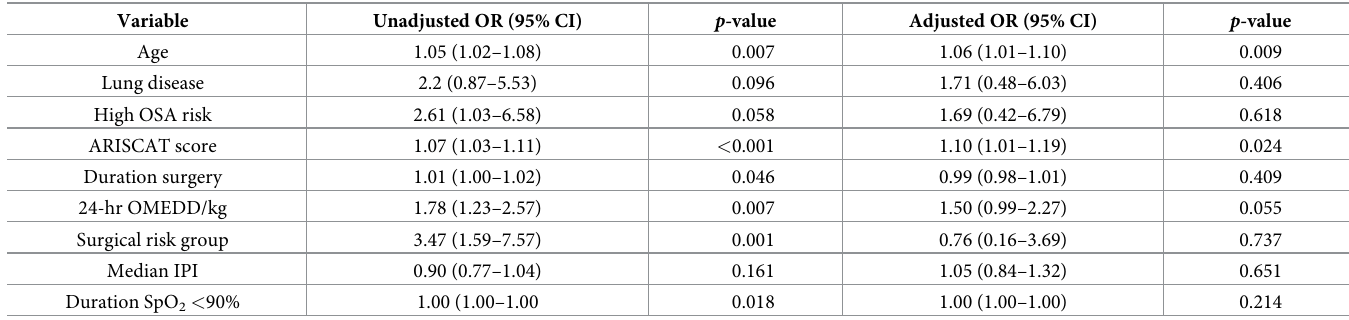
Table 3. Variables considered in the multivariable logistic regression analysis for PPCs.